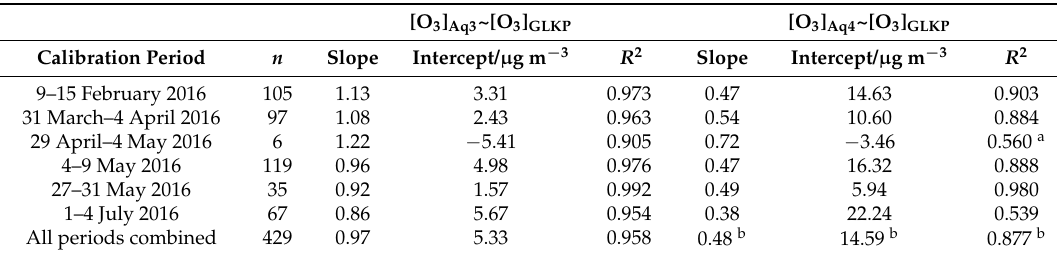
Table 2. Regression statistics of Aeroqual O 3 monitor concentrations ([O 3 ] Aq3 and [O 3 ] Aq4 ) against